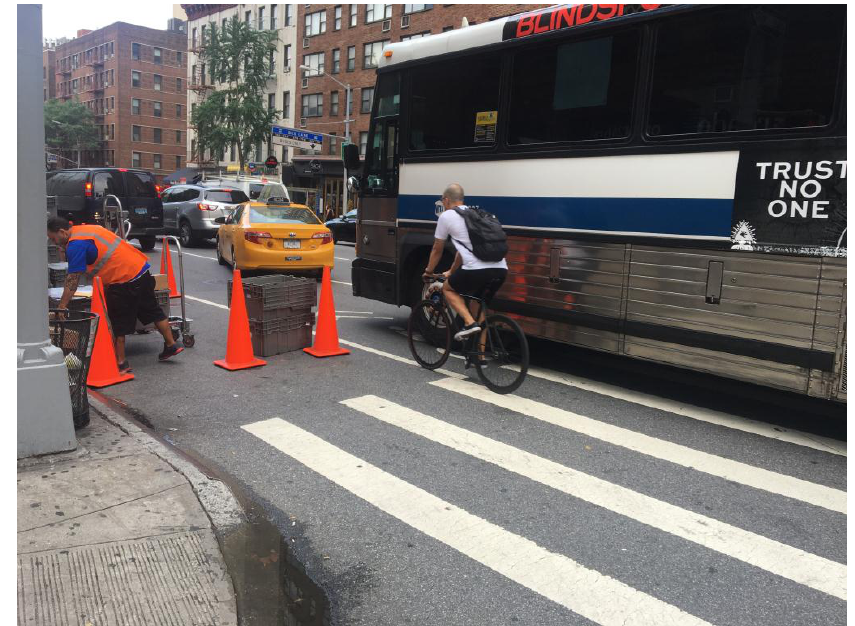
Figure 4. Bicyclist navigating a sharrow. This street location in New York City corresponds to the critical hotspot on Second Avenue (Figure 2b). Sharrow riders merge with automobiles making left hand turns. Bicyclists are instructed to ride in a shared lane with traffic, but often they pass automobiles rather than using the lanes as intended. Automobile drivers are unaccustomed to having bicyclists in their left blind spot. Qualitative investigations of scene locations may improve understanding of why design features are associated with increased ISS and frequency of